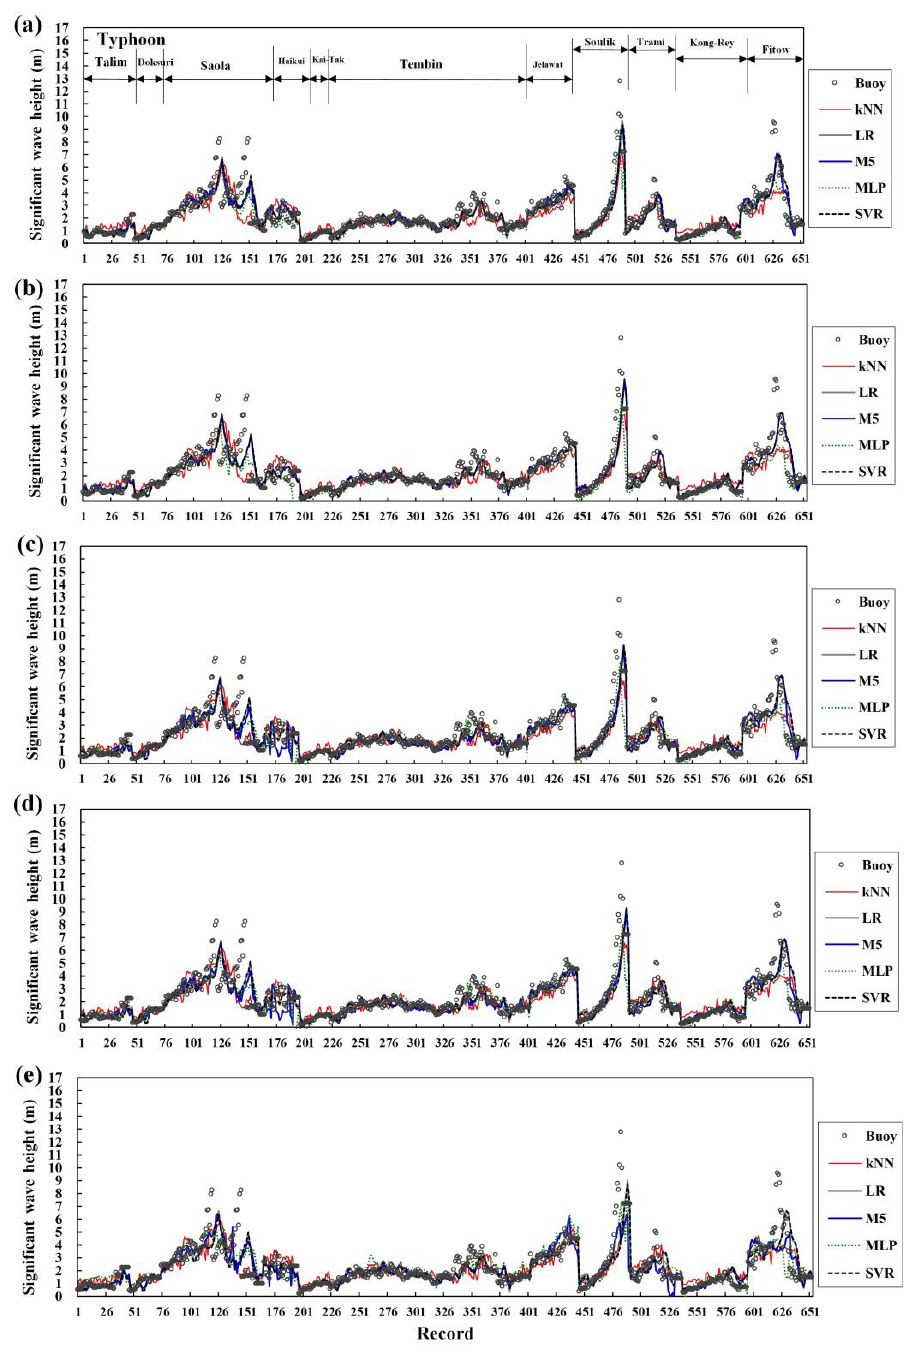
Figure 10. Predictions of wave heights using TV90 case for lead time at: ( a ) 2 h, ( b ) 3 h, ( c ) 4 h, ( d ) 5 h, and ( e ) 6